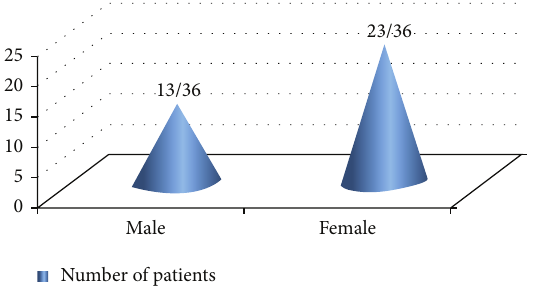
Figure 7: Gender distribution of BCC.